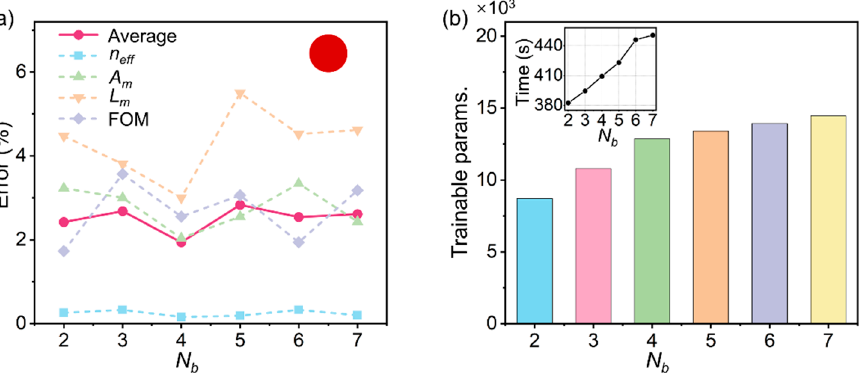
Figure 3. Optimized layout for the base net. ( a ) Dependence of errors on the number of hidden layers ( N b ) in the base net. Dashed lines with squares, up triangles, down triangles, and diamonds represent the individual error of effective index ( n eff ), mode area ( A m ), propagation length ( L m ), and figure of merit (FOM), respectively. Red solid line with dots: overall performance in terms of the average error. Inset: schematic illustration of the geometry of the circular MNW. ( b ) Number of trainable parameters vs. N b . Inset: an increasing training time with the increase in N b .